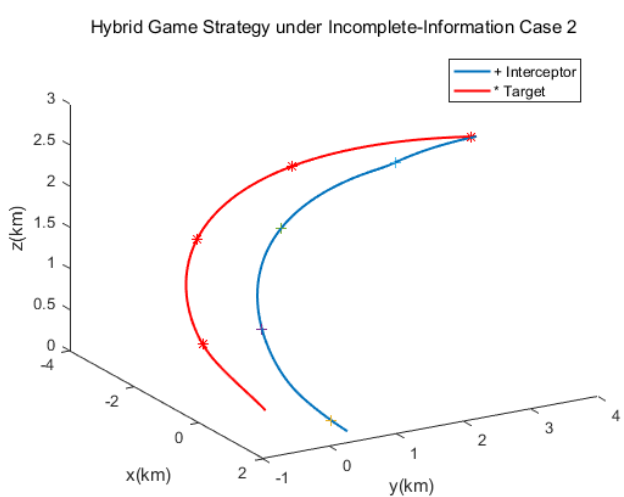
Figure 10. Spacecraft trajectories of the hybrid game strategy.